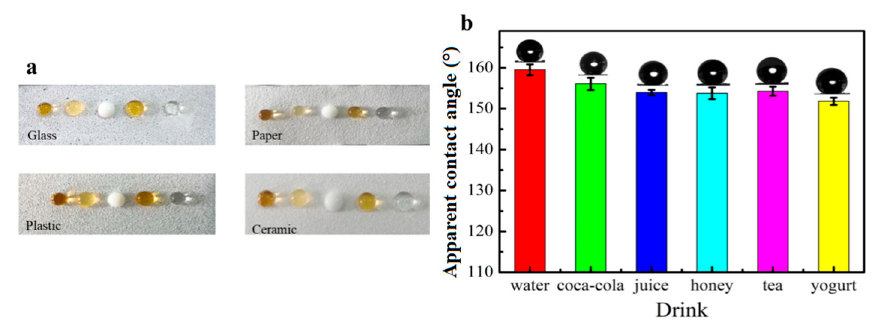
Figure 5. ( a ) Photographs of Coca Cola, black tea, yogurt, honey and water droplets on different coated materials and ( b ) the apparent contact angles and sliding angles of different liquid food on coated glass.